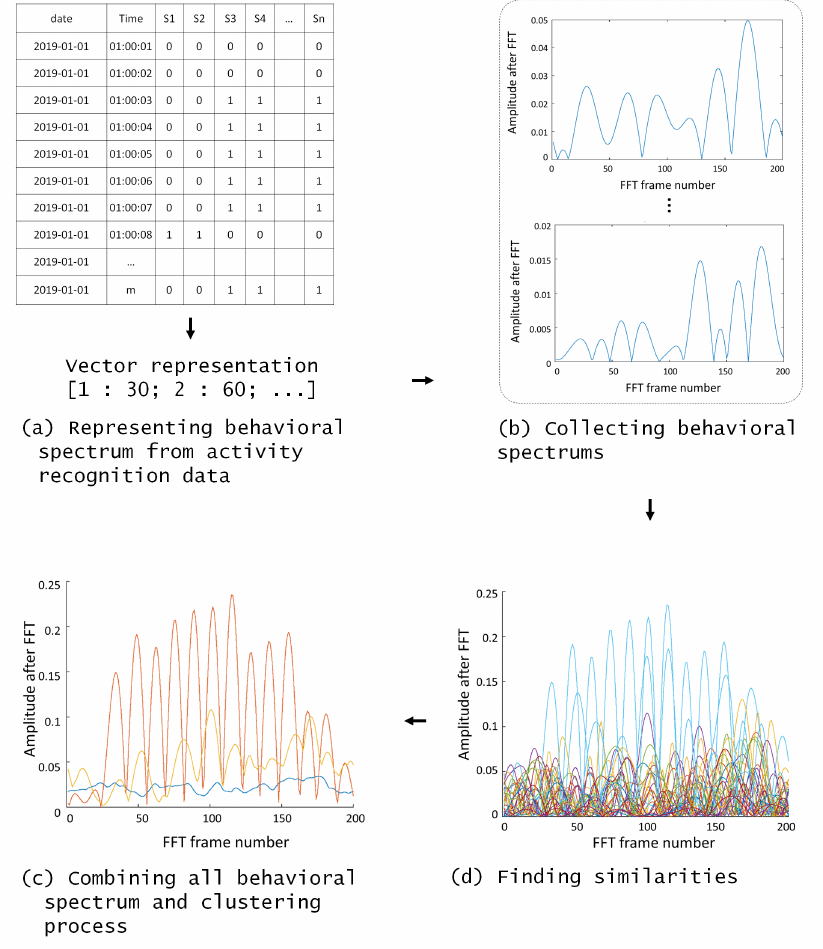
Figure 3. Overview of the methodology used to extract habits from the activity recognition dataset. ( a ) extracting the sequence and duration from the activity recognition system [19], and representing them as vectors; ( b ) the vectors represent a periodic signal called the behavioral spectrum. Note we coded to invert the signals of negative part to positive, in order to use only positive values when clustering the signals; ( c ) clustering all behavioral spectra; ( d ) the clustered signals are